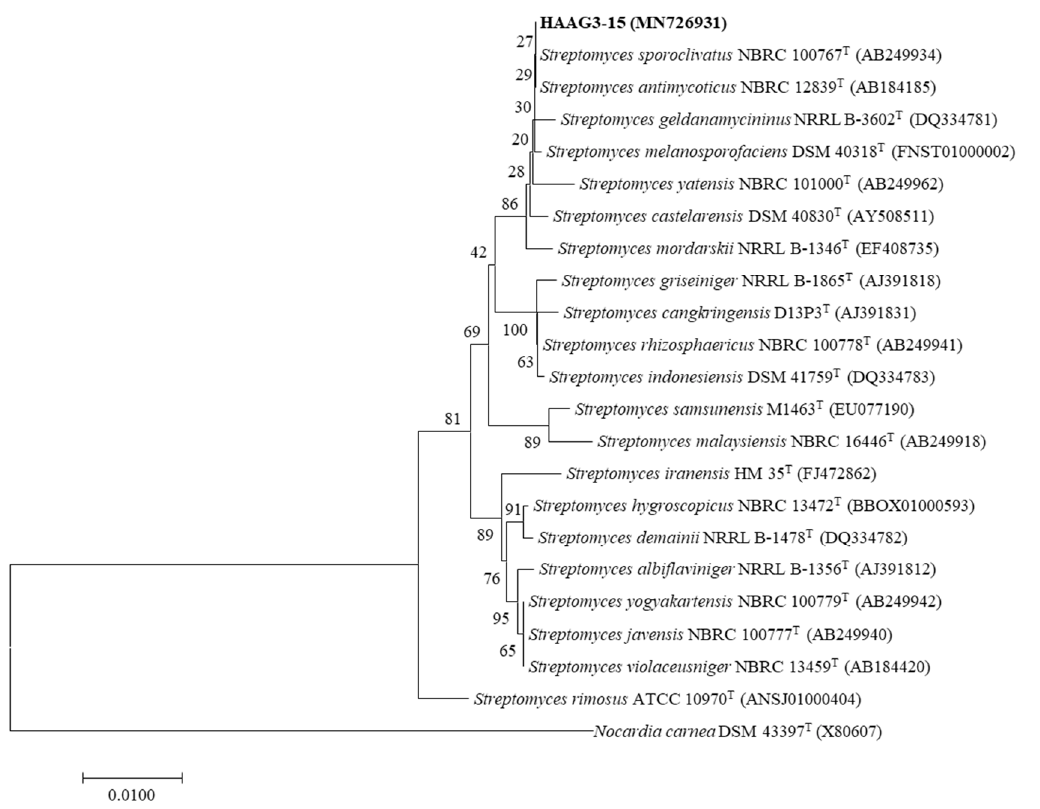
Figure 7. Neighbor-joining phylogenetic tree, based on almost-complete 16S ribosomal RNA (rRNA) gene sequences, showing the phylogenetic relationships of strain HAAG3-15 and the closest strains within the genus Streptomyces . Nocardia carnea DSM43397 T was used as the outgroup. Bar, 0.0100 substitutions per nucleotide position.